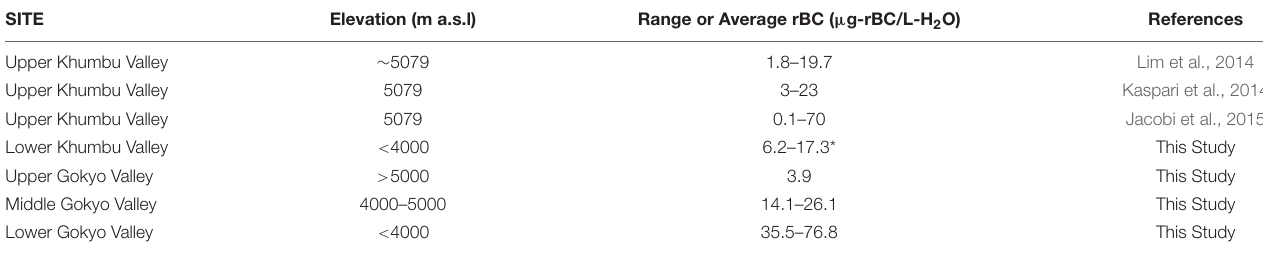
TABLE 2 | Refractory black carbon (rBC) concentrations from this study of snow on land in the Gokyo Valley compared to previously published rBC concentrations in surface snow from the nearby Khumbu Valley at Pyramid Station.